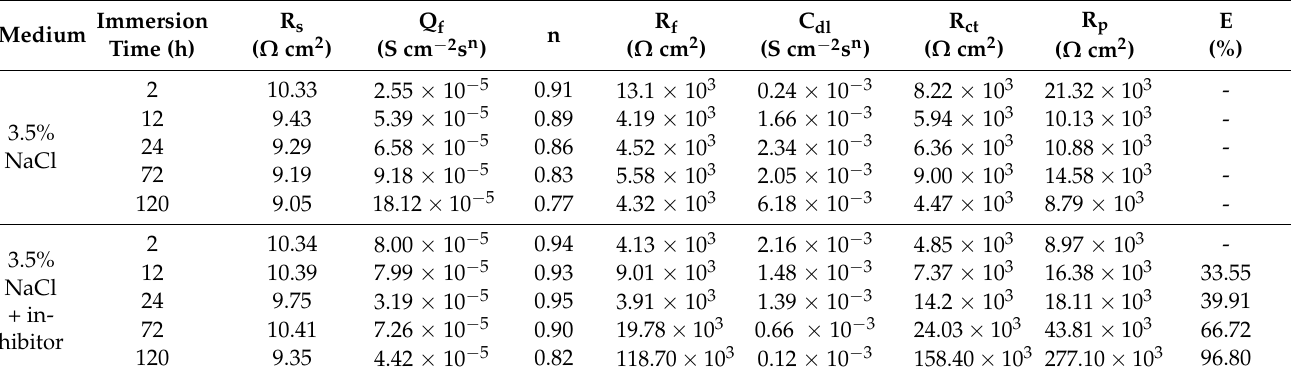
Table 1. Electrochemical parameters extracted from EIS curves for AA2024-T3 in 3.5% NaCl in the absence and presence of the (TEPA/CSS) 2 Ce corrosion inhibitor over